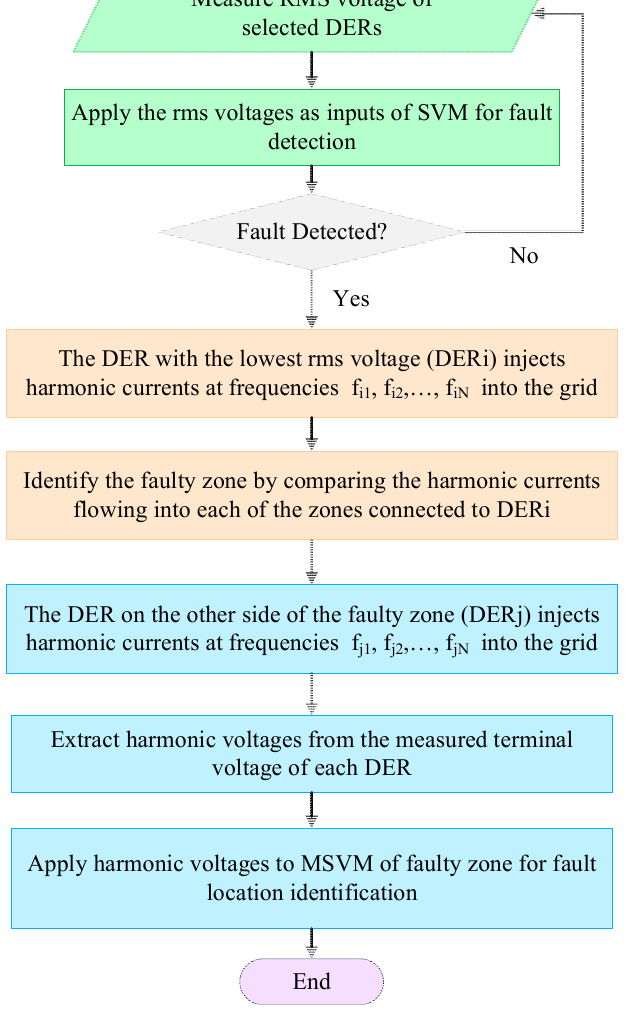
Figure 1. Flowchart of the proposed algorithm. MSVM, multi-class support vector machine; DER, distributed energy resource; RMS, root mean square.